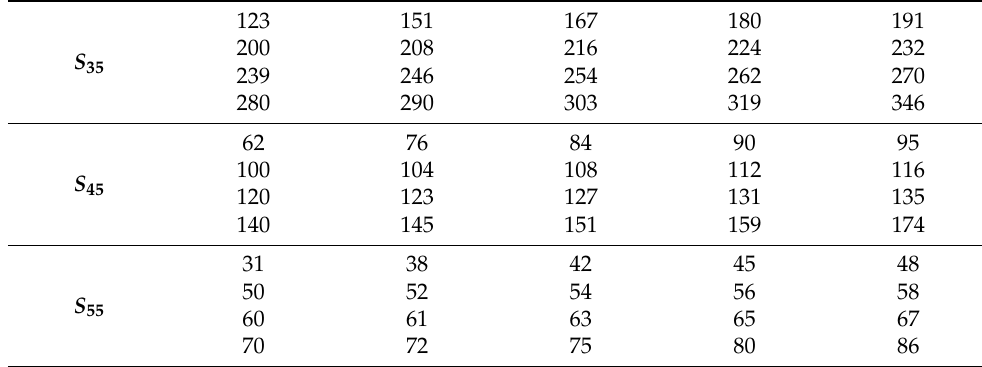
Table 4. Simulated failure cycles for batteries at several stress levels.